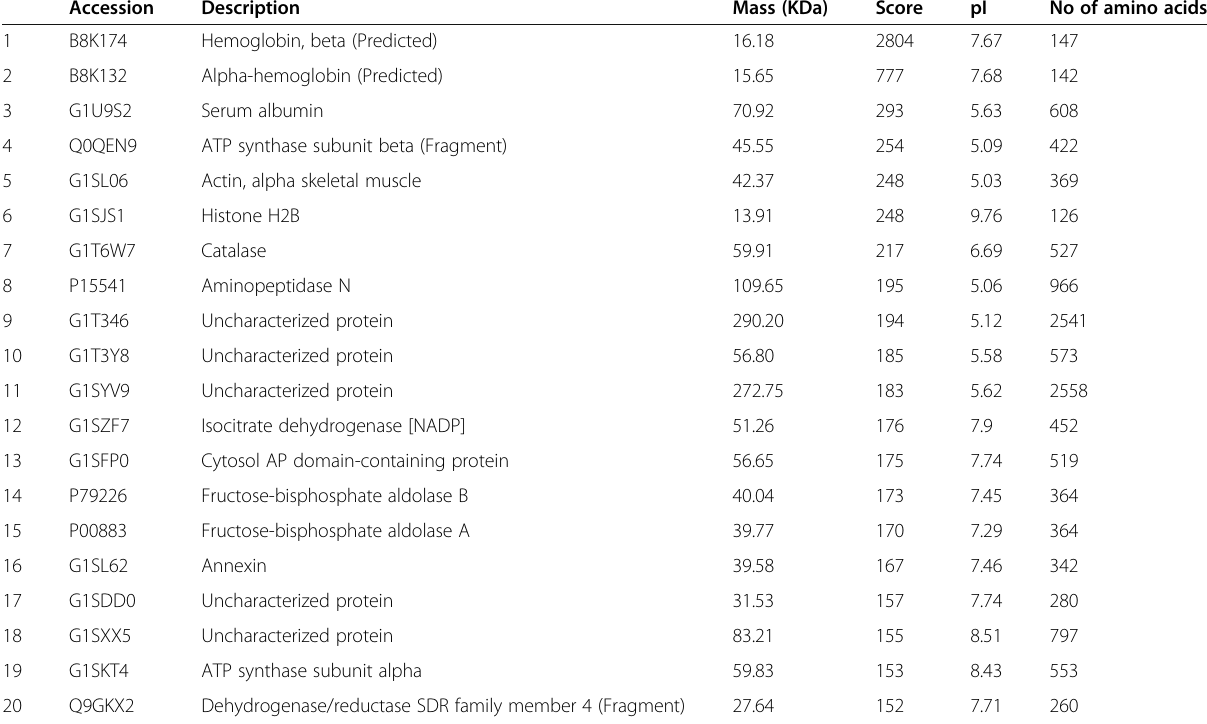
Table 2 List and physicochemical properties of topmost abundant proteins in the liver proteome of the rabbits in the treatment